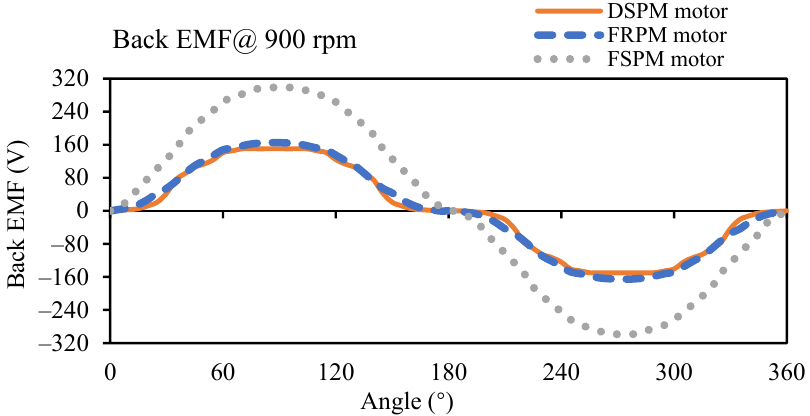
Figure 5. Back-EMF waveforms of three AF-DR motors.